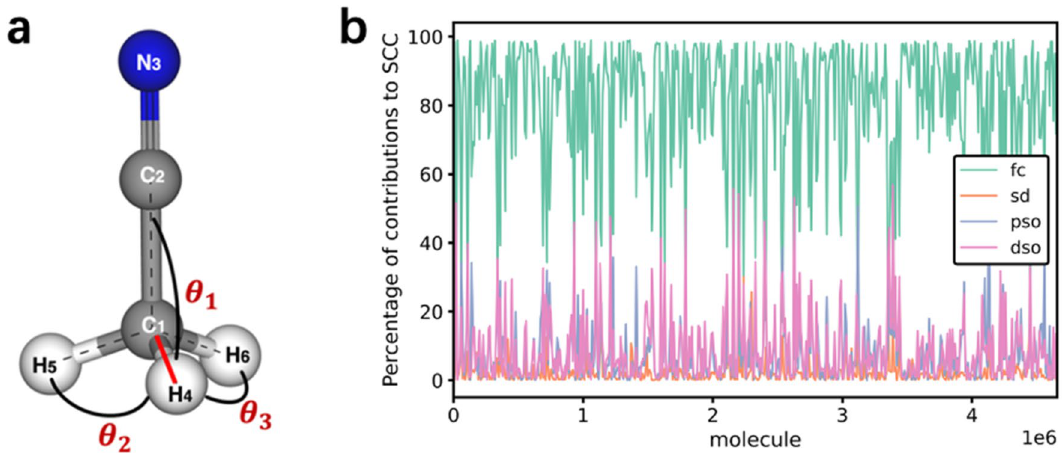
Figure 7. Bond angle for SCC. ( a ) Bond angle attention mechanism. θ i (θ 1 , θ 2 and θ 3 ) represent the bond angles between the bond ( −−−→ H 4 C 1 ) and the adjacent bonded atoms (C 2 , H 5 and H 6 ) respectively. ( b ) Percentage of contributions to SCC. SCC is in most cases determined by the Fermi